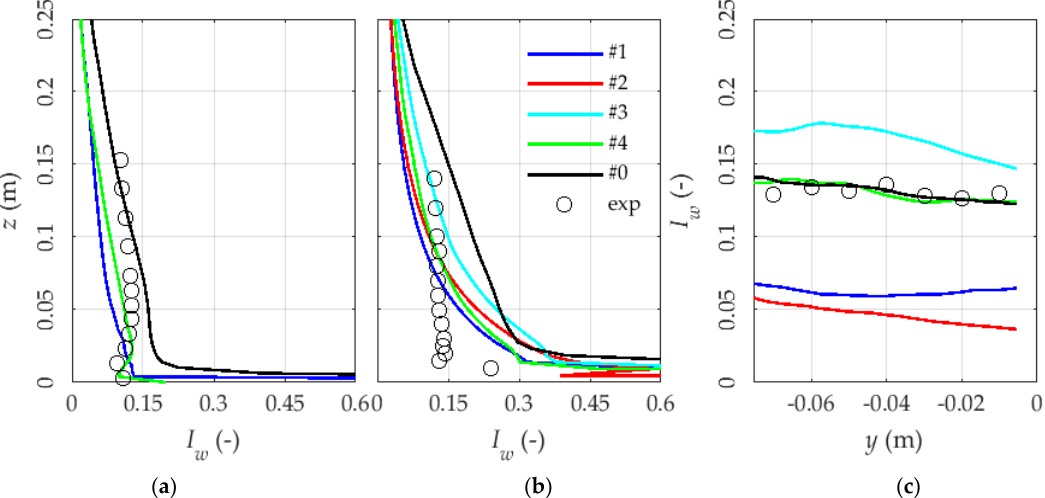
Figure 10. Vertical turbulence intensity at the rooftop of the Muirhead tower ( a ) and Biosciences building ( b , c ).